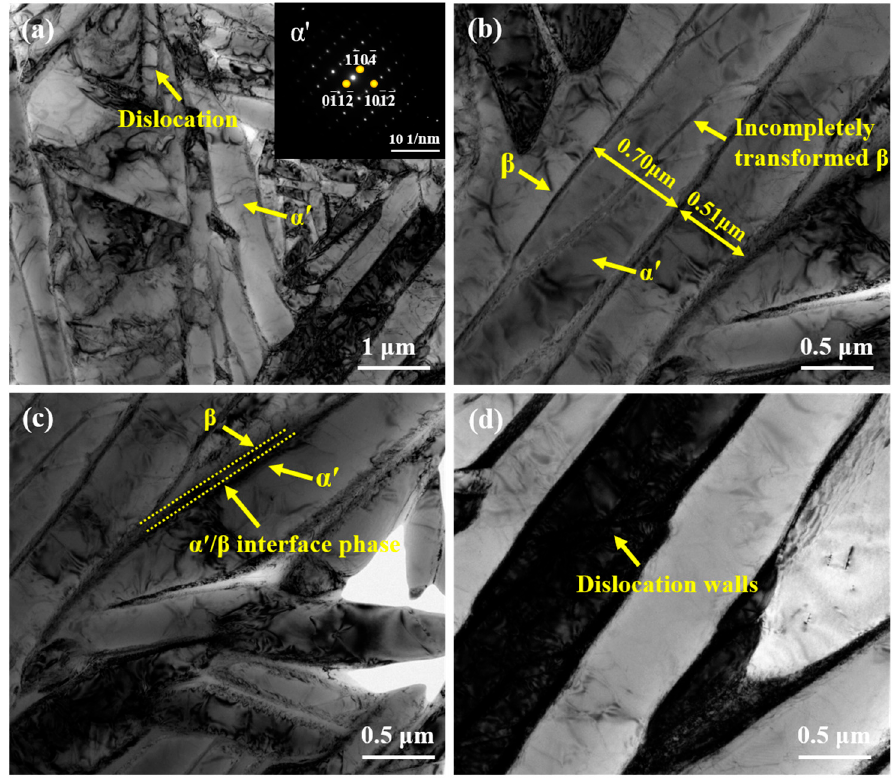
Figure 5. TEM morphology of WM: ( a ) low magnification morphology of WM; ( b ) high magnification morphology; ( c ) α ’/ β interface phase; ( d ) dislocation walls.